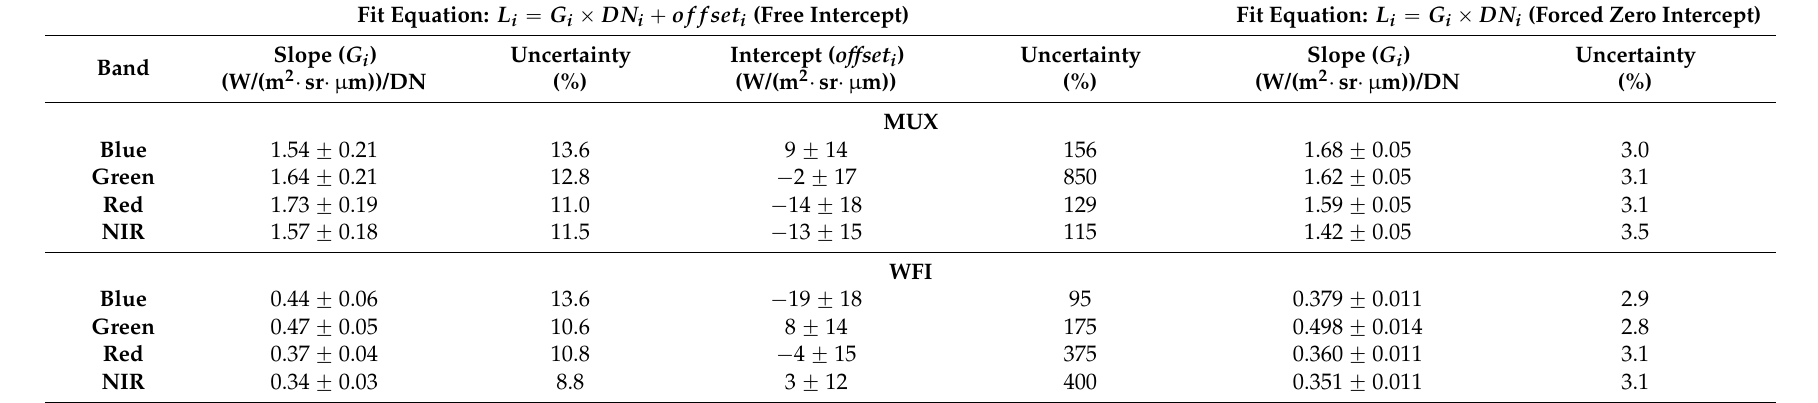
Table 8. Linear fits results corresponding to the plots shown in Figures 9 and